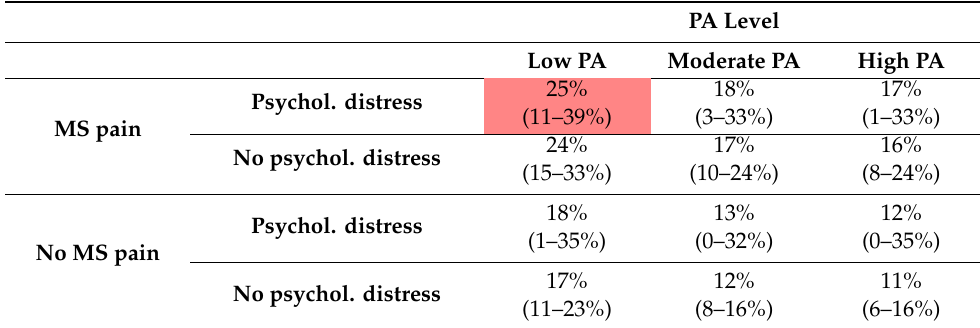
Table3. Riskmatrixmodelforgirls. Probabilityofobesity(BMI ≥ 30kg / m 2 )(percentage,(95%confidence interval (CI)) in young adulthood.